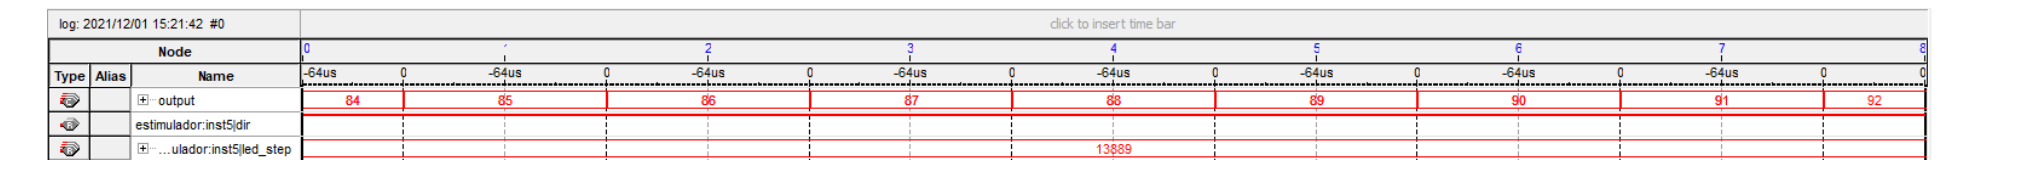
Figure 17. Simulation of a SSAC ±5° and 0.1 Hz stimulus for a 50 cm patient-stimulus distance (-5° = position 109, +5° = position 127).